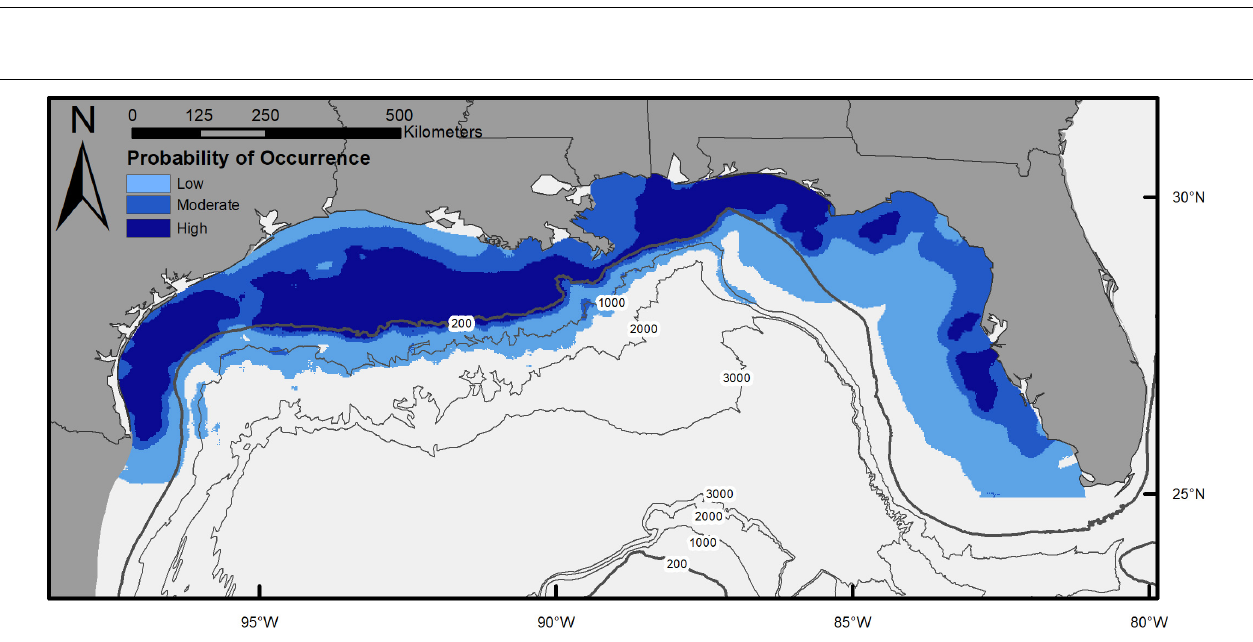
FIGURE 2 | Response plots from generalized additive model (GAM) of environmental variables relative to the presence–absence of scalloped hammerheads throughout the northern Gulf of Mexico.